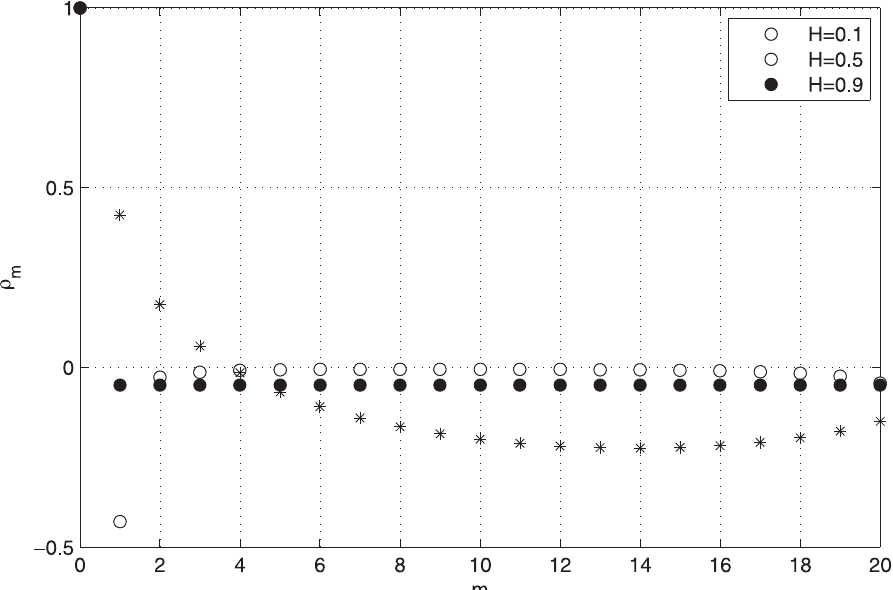
Fig 2. Autocorrelation function of dfBB for H = 0.1 (empty circle), H = 0.5 (full circle) and H = 0.9 (star).